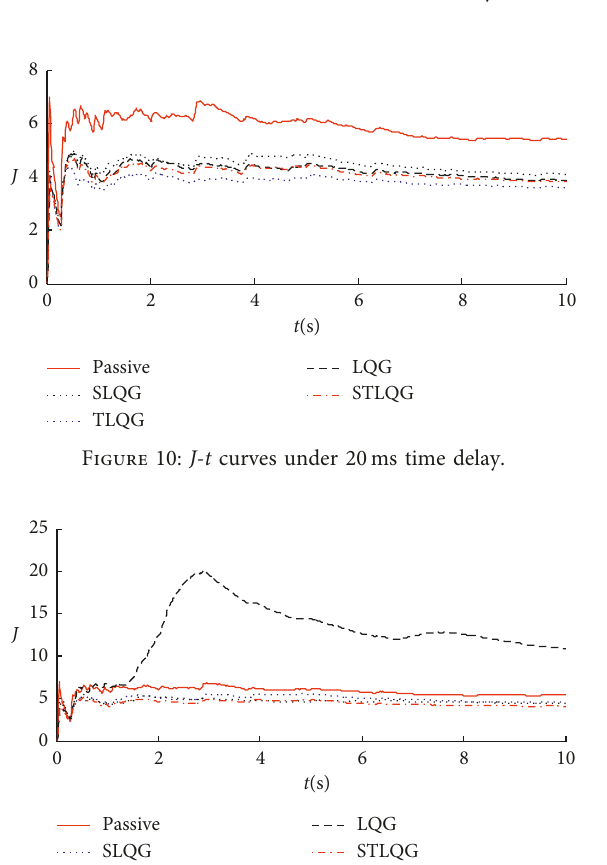
Figure 9: J - t curves under 15ms time delay.